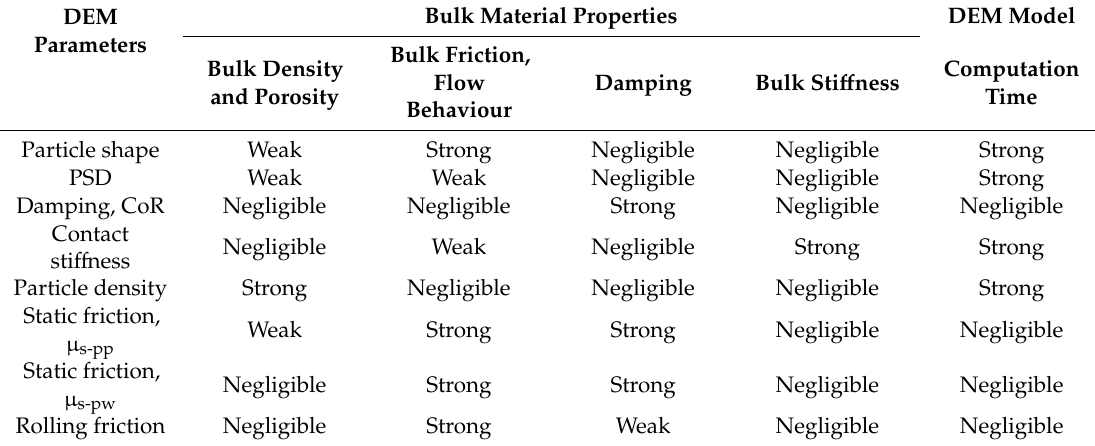
Table 1. Relation between DEM parameters and material bulk behavior